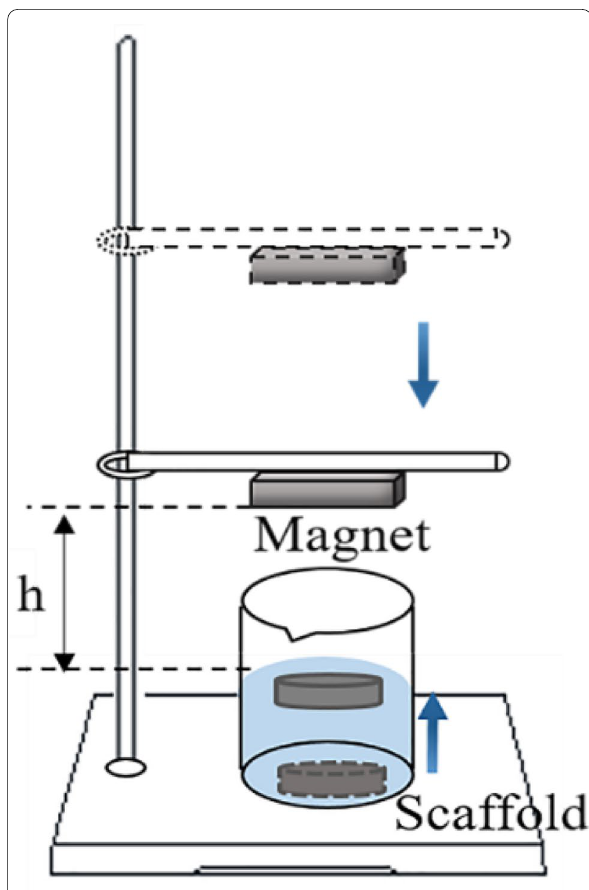
Fig. 3 Magnetic responsiveness of the scaffolds measurement. h is the distance between the magnet and the liquid level when the scaffolds approached the liquid